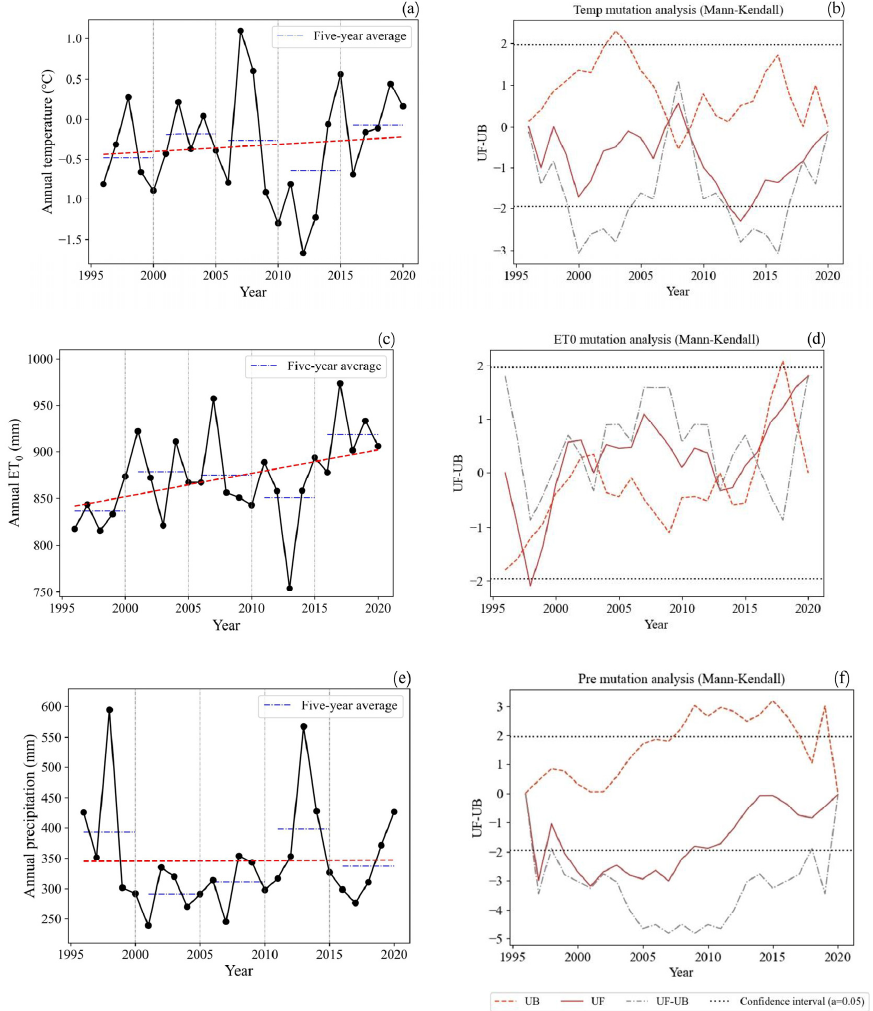
Figure 5 . Time series variation and Mann ‐ Kendall mutation detection of main climate indexes in forest–steppe ecotone . ( a , c , e ) showed the interannual variation of temperature, potential evapotranspiration, and precipitation, respectively. ( b , d , f ) showed Mann ‐ Kendall mutation detection of temperature, potential evapotranspiration, and precipitation, respectively.